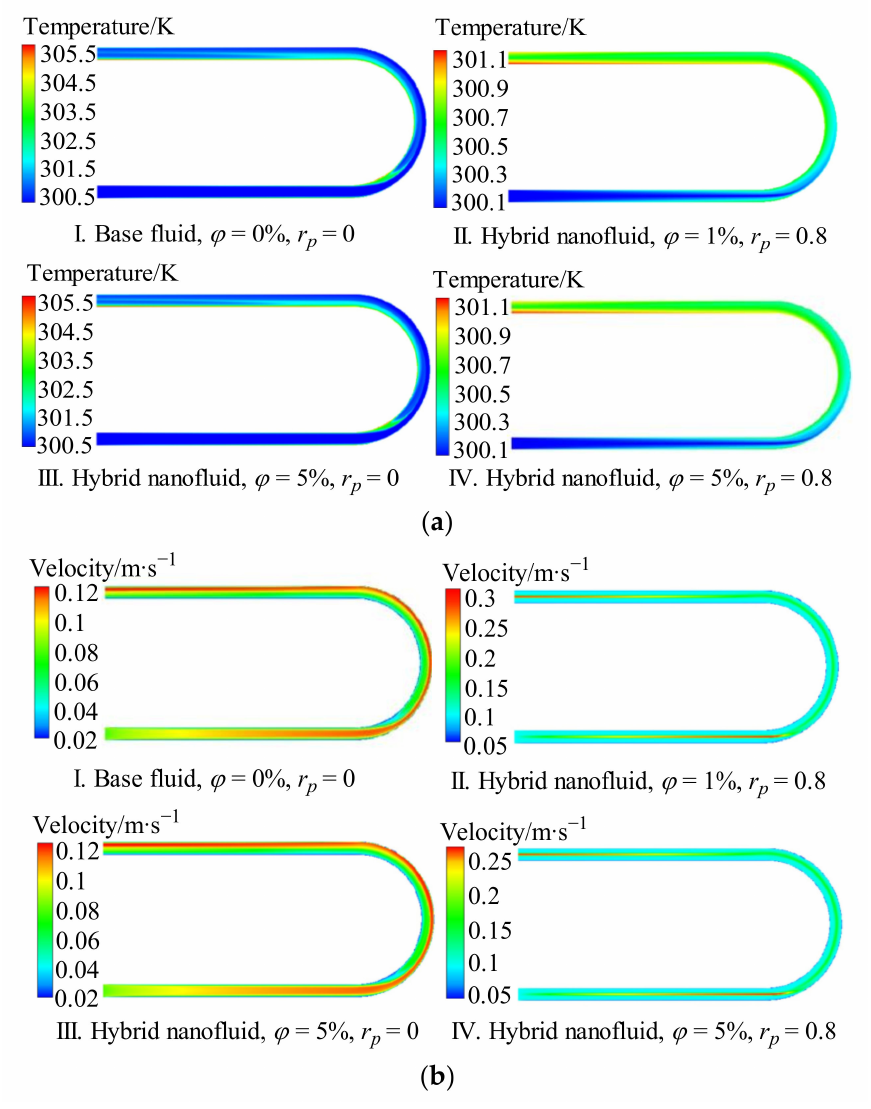
Figure 5. Temperature and velocity contours of mixed nano-fluids [102]. Moghadasi et al., (2020). ( a ) Temperature contours with mixed nano-fluids of different volume fractions. ( b ) Velocity contours using mixed nano-fluids of different volume